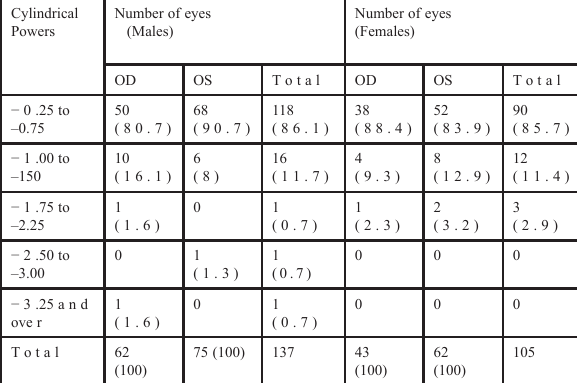
Table 4 Distribution of magnitudes of astigmatic powers (percentages in brackets) in the right and left eyes of the subjects. Low astig- matic powers were more common than the other categories.